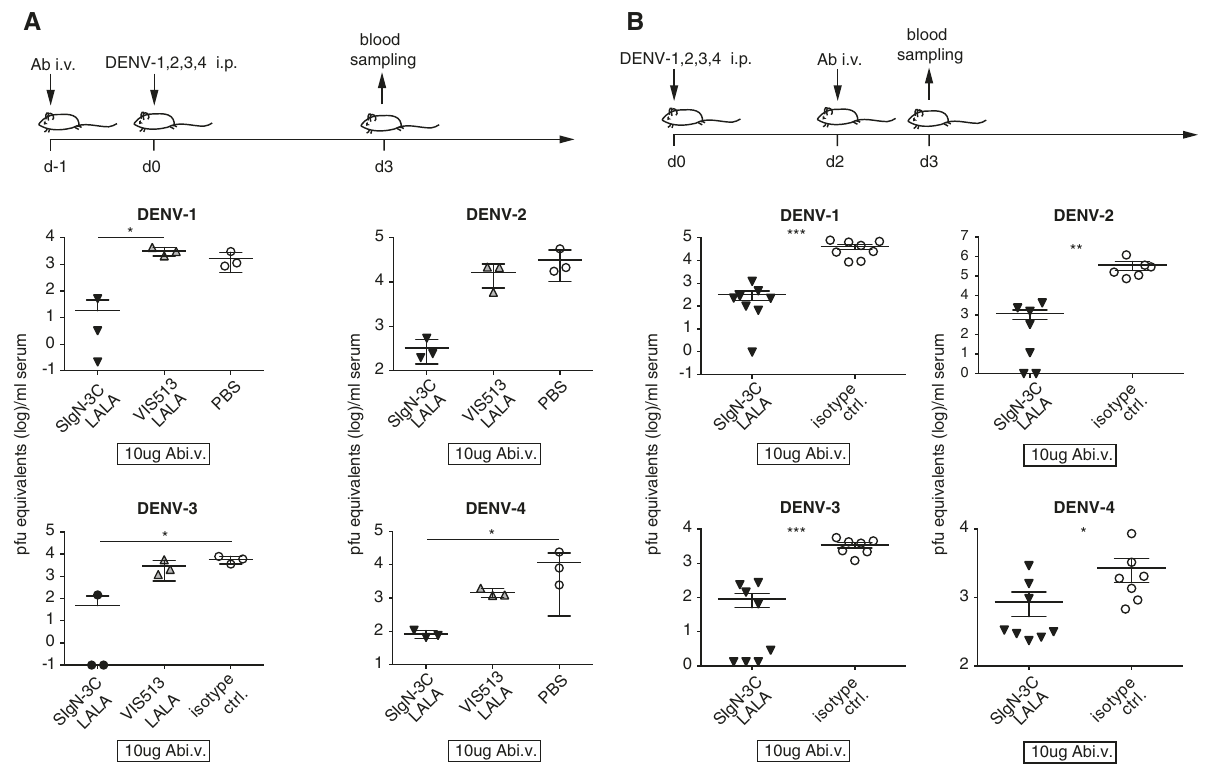
Fig. 4 Protection against all four DENV serotypes. a Ef fi cacy of SIgN-3C-LALA and 513-LALA in the prophylactic setting. 10 μ g of antibody for DENV-1- and DENV-2 and 100 μ g antibody for DENV-3 and DENV-4 were given i.v., followed by a challenge with the individual DENV serotypes. Each symbol represents one mouse and means ± SD are shown. Kruskal Wallis test with Dunn multiple comparisons test DENV-4 * = 0.022, DENV-3 * = 0.032, DENV-1 * = 0.033; means ± SD are shown. For testing of DENV-1 and -2 IFNAR mice were used. b Ef fi cacy of SIgN-3C-LALA in the therapeutic setting. Results are pooled from two independent experiments with four mice each per group, means ± SEM are shown. Mann – Whitney test; DENV-1: ***:0.0002, DENV-2 ***:0.0012, DENV-3: ***:0.0003, DENV-4: